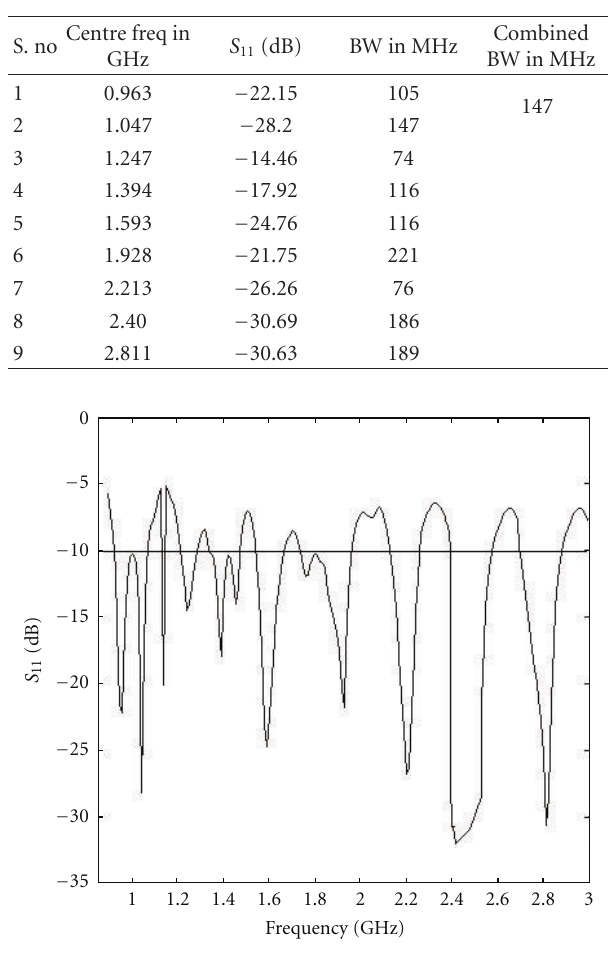
Figure 7: Measured S 11 of self-a ffi ne fractal antenna structure.